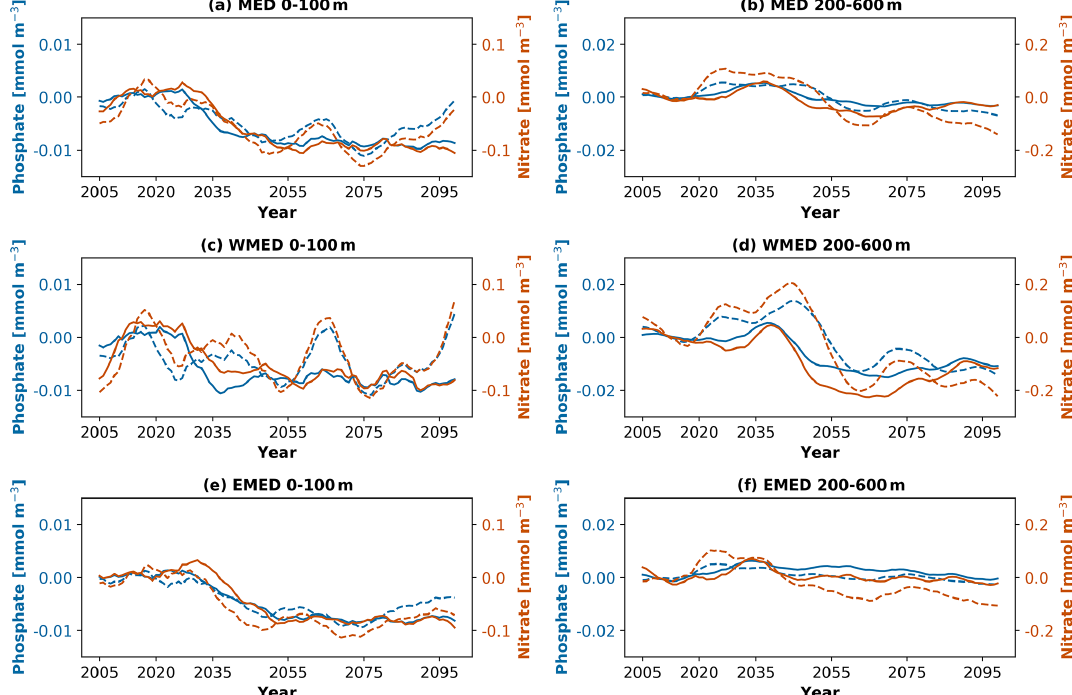
Figure 7. Yearly time series for the period 2005–2099 of phosphate (blue, in mmolm − 3 ) and nitrate (dark orange, in mmolm − 3 ) anomalies for the emission scenarios RCP8.5 (solid lines) and RCP4.5 (dashed lines) in the Mediterranean Sea (MED, a–b ), Western Mediterranean (WMED, c–d ) and Eastern Mediterranean (EMED, e–f ) for the 0–100m (a, c, e) and 200–600m (b, d, f) layers. The yearly time series have been smoothed using the 10-year running mean.